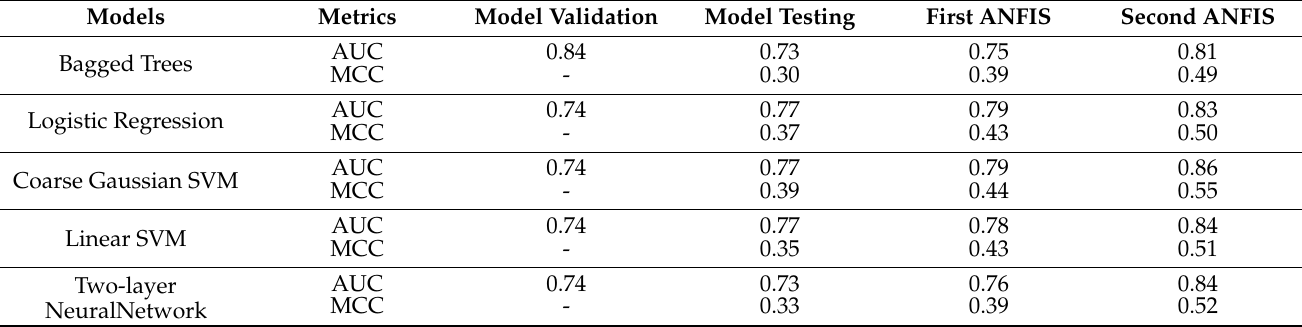
Table 13. Test results for AHI 30.